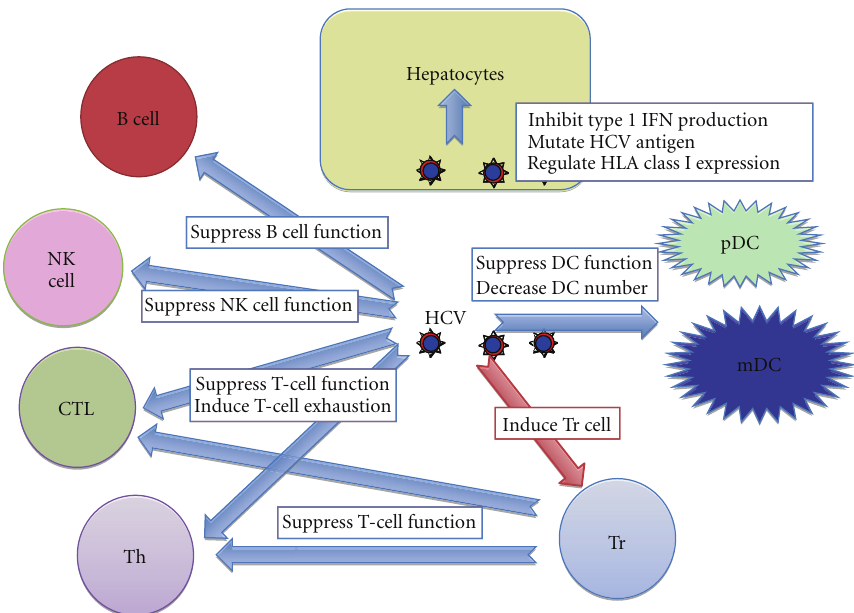
Figure 3: Immune suppressive mechanisms in HCV infection. HCV mutates its amino acid sequence to escape from immune surveillance, inhibits type 1 IFN production, and suppress NK cell function, T-cell function, and DC function. In addition, HCV induces Tr cells, which suppress T-cell function. Abbreviated terms: CTL, Cytotoxic T lymphocyte; pDC, plasmacytoid dendritic cells; mDC, myeloid dendritic cells; Th cell, helper T cell; NK cell, natural killer cell; IFN,